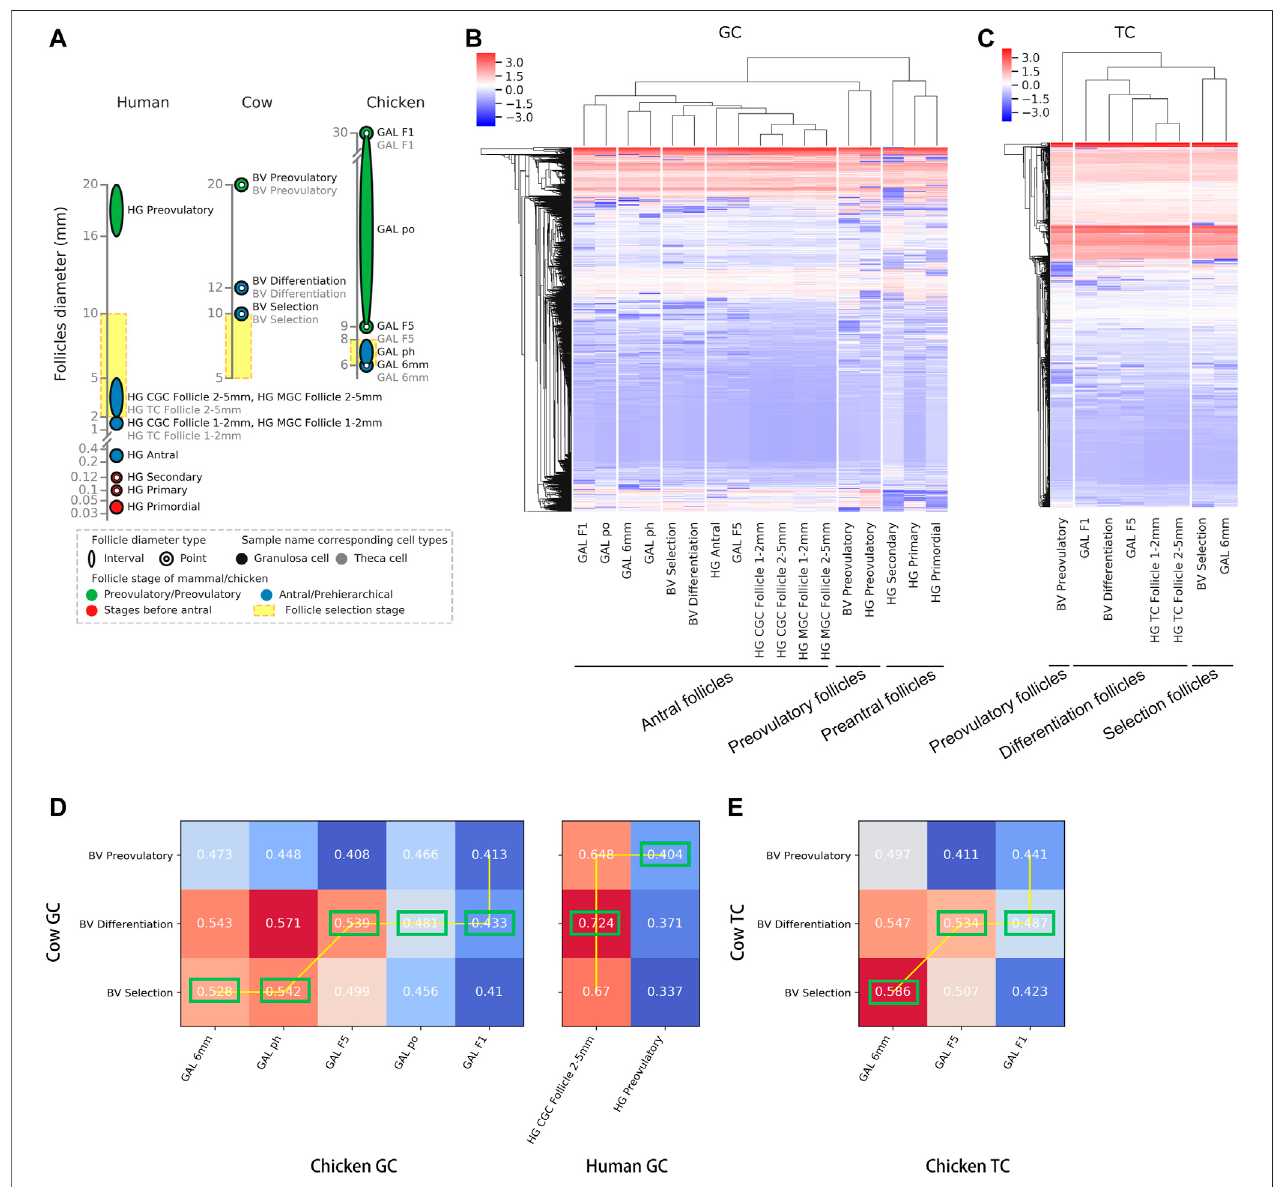
FIGURE1| Correspondencebetweenthestagesoffollicledevelopmentinoviparousandviviparousanimals. (A) Speciesandstagesoffolliclesamples.Eachcircle orellipserepresentsatypeofsample. (B,C) HierarchicalclusteringofGCsandTCsbasedongeneexpressionateachstageoffollicledevelopmentforeachspecies.The colours in the heatmap correspond to gene expression after standardization of the z-score. (D,E) Correlations (Spearman ’ s correlation coef fi cients) of GCs and TCs at eachdevelopmentalstageafterfollicleselectionbetweenchickensandbovinesandbetweenhumansandbovines.Thebestalignmentsareconnectedbyayellow line, and the best corresponding stages are marked by green